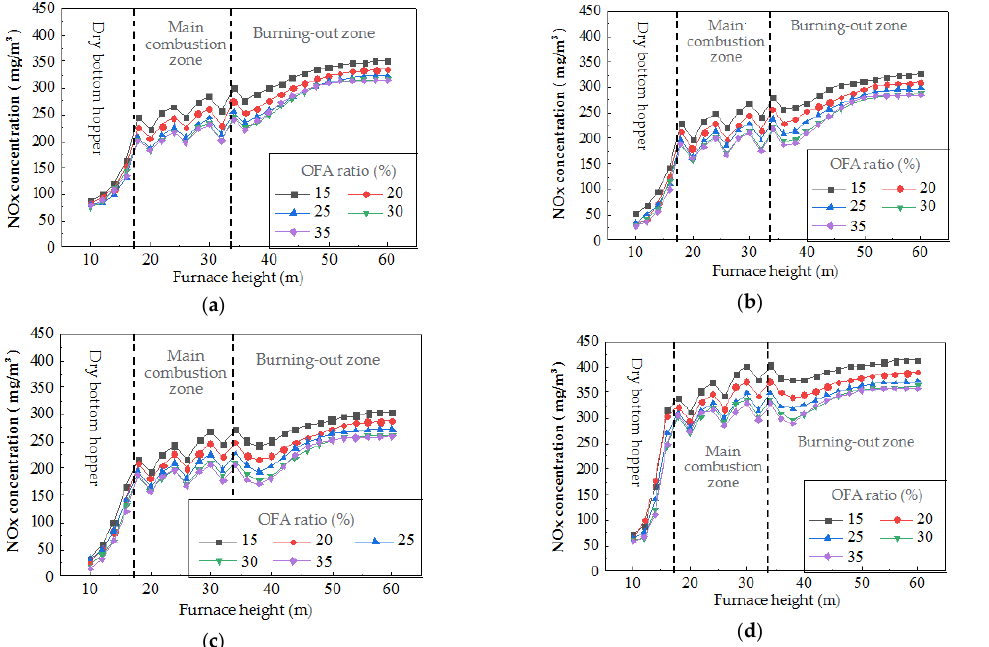
Figure 13. Variation in NOx concentration along the furnace height under different OFA ratios: ( a ) Variation in NOx concentration along the furnace height under different OFA ratio and 600 MW boiler load; ( b ) Variation in NOx concentration along the furnace height under different OFA ratio and 500 MW boiler load; ( c ) Variation in NOx concentration along the furnace height under different OFA ratio and 400 MW boiler load; ( d ) Variation in NOx concentration along the furnace height under different OFA ratio and 250 MW boiler load.